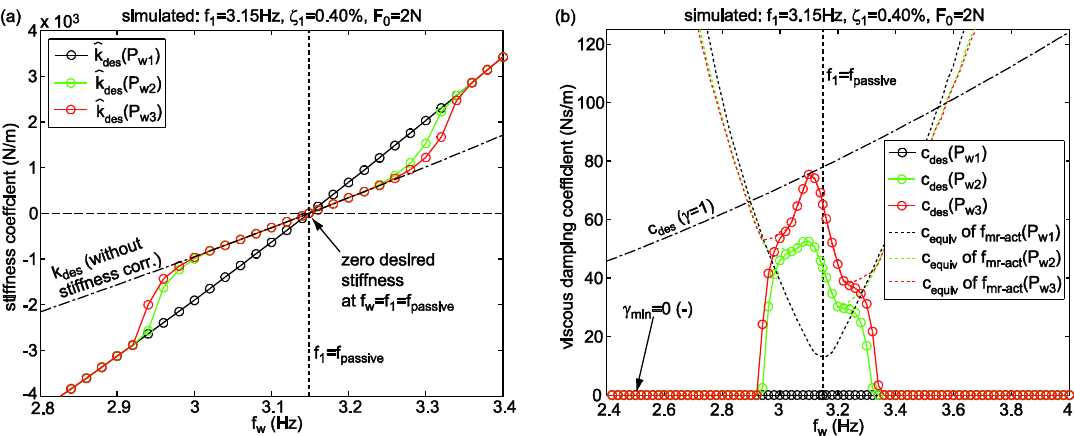
Figure 5. Simulated ( a ) desired corrected stiffness and ( b ) desired viscous damping coefficient (including damping gain ) accompanied by equivalent (actual) viscous damping coefficient.